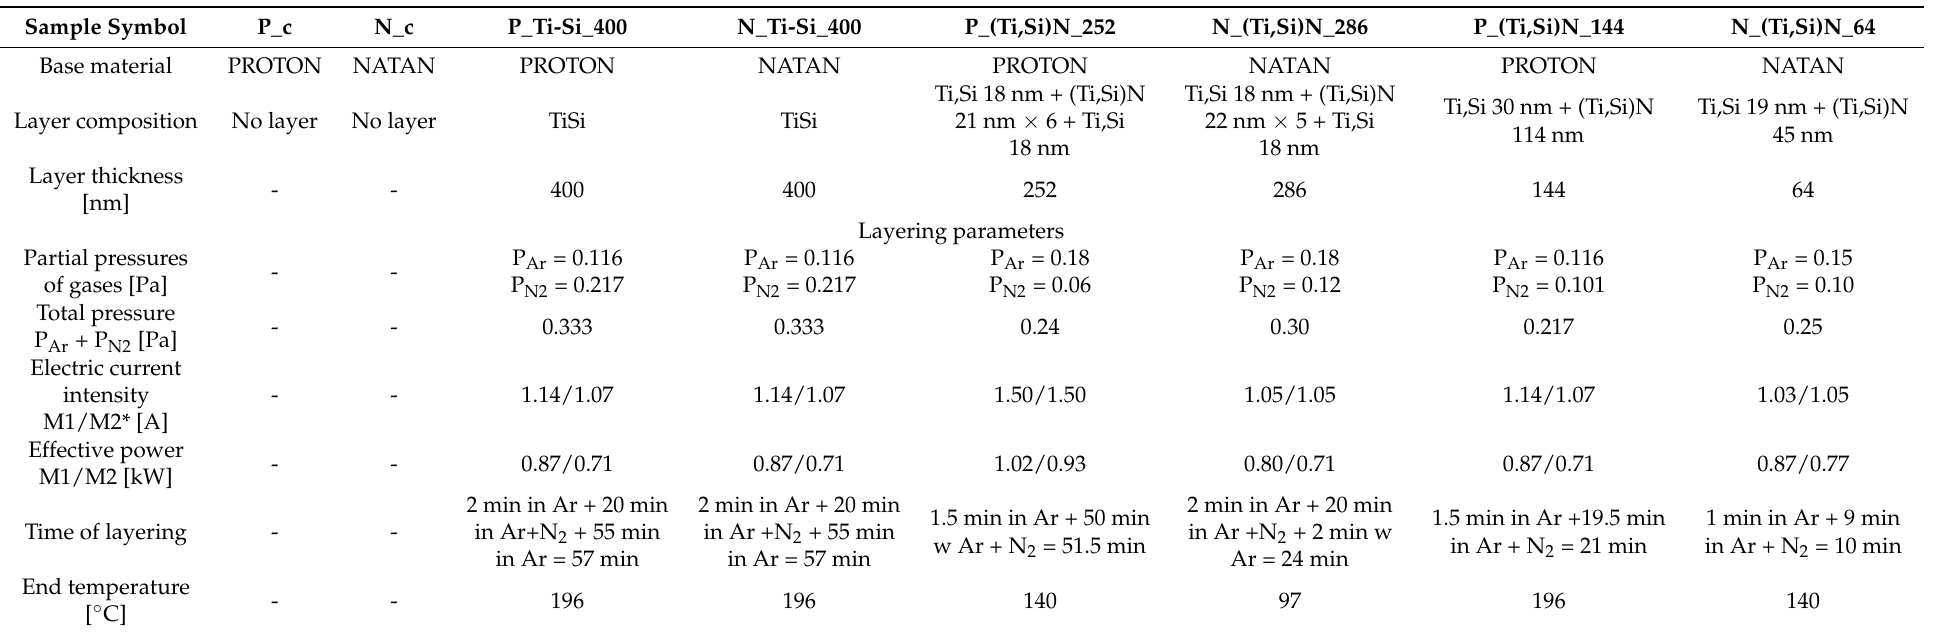
Table 2. Layering parameters of tested